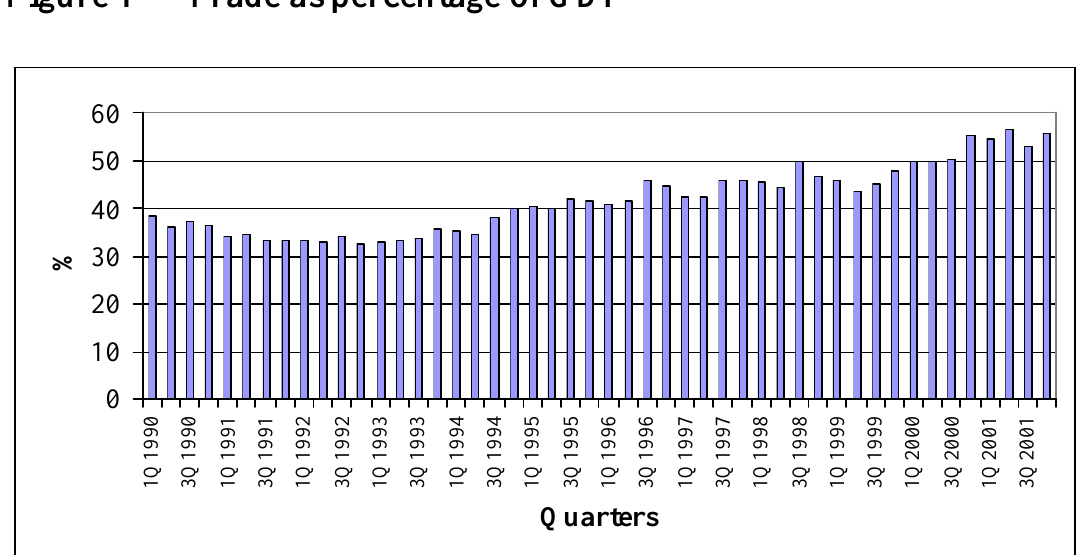
Trade as percentage of GDP